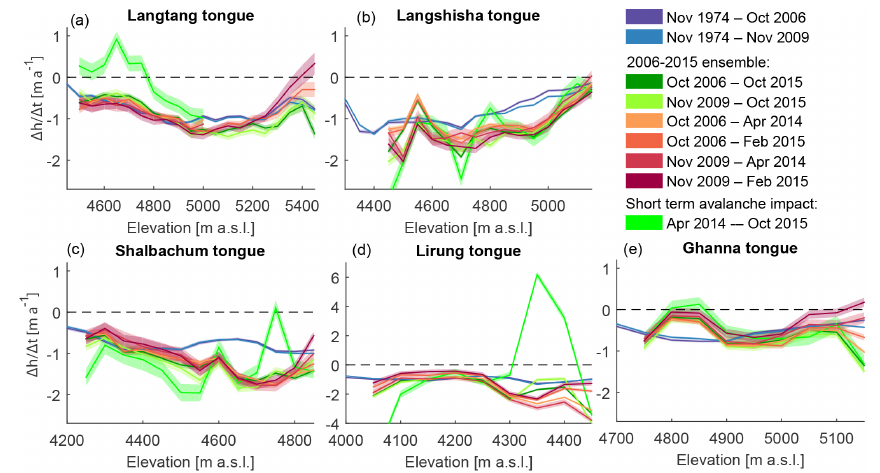
Figure 9. Altitudinal distribution of mean annual elevation change ( (cid:49)h/(cid:49)t ) over 50m elevation bands of debris-covered tongues (debris- covered area of each glacier excluding tributary branches). Uncertainty bounds correspond to uncertainty as a function of elevation derived for each (cid:49)h/(cid:49)t map individually (Fig. 3).